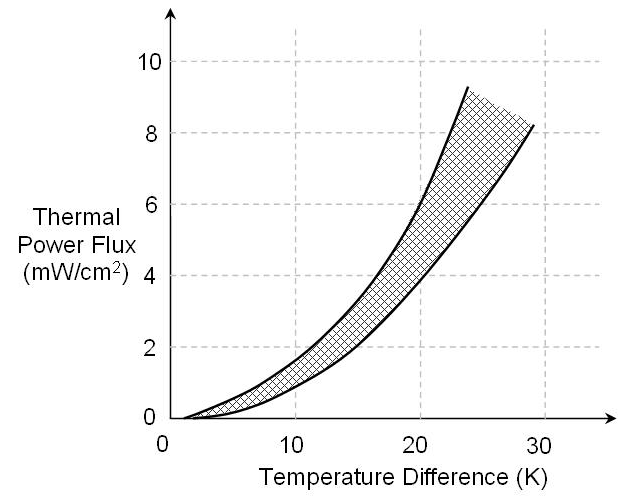
Figure 12 . Maximum power flux generated by example Thermoelectric Generators